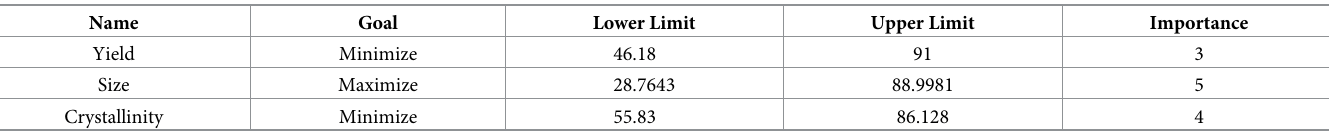
Table 8. Design optimization parameter.